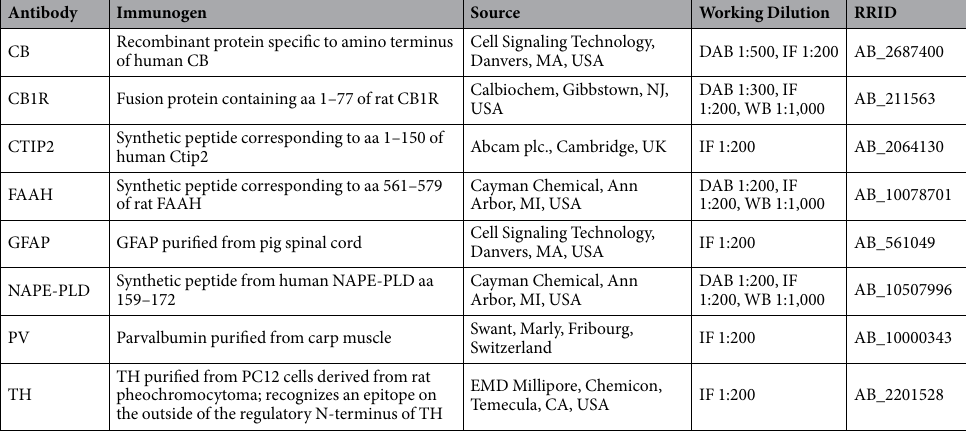
Table 1. Primary antibodies used in this study. CB: Calbindin-d28k; CB1R: cannabinoid receptor type 1; CTIP2: CTIP2 transcription factor; DAB: 3,3 ′ -diaminobenzidine immunostaining; FAAH: fatty acid amide hydrolase; GFAP: glial fibrillary acidic protein; IF: immunofluorescence; NAPE-PLD: N-acyl phosphatidylethanolamine- specific phospholipase D; PV: parvalbumin; TH: tyrosine hydroxylase; WB: Western